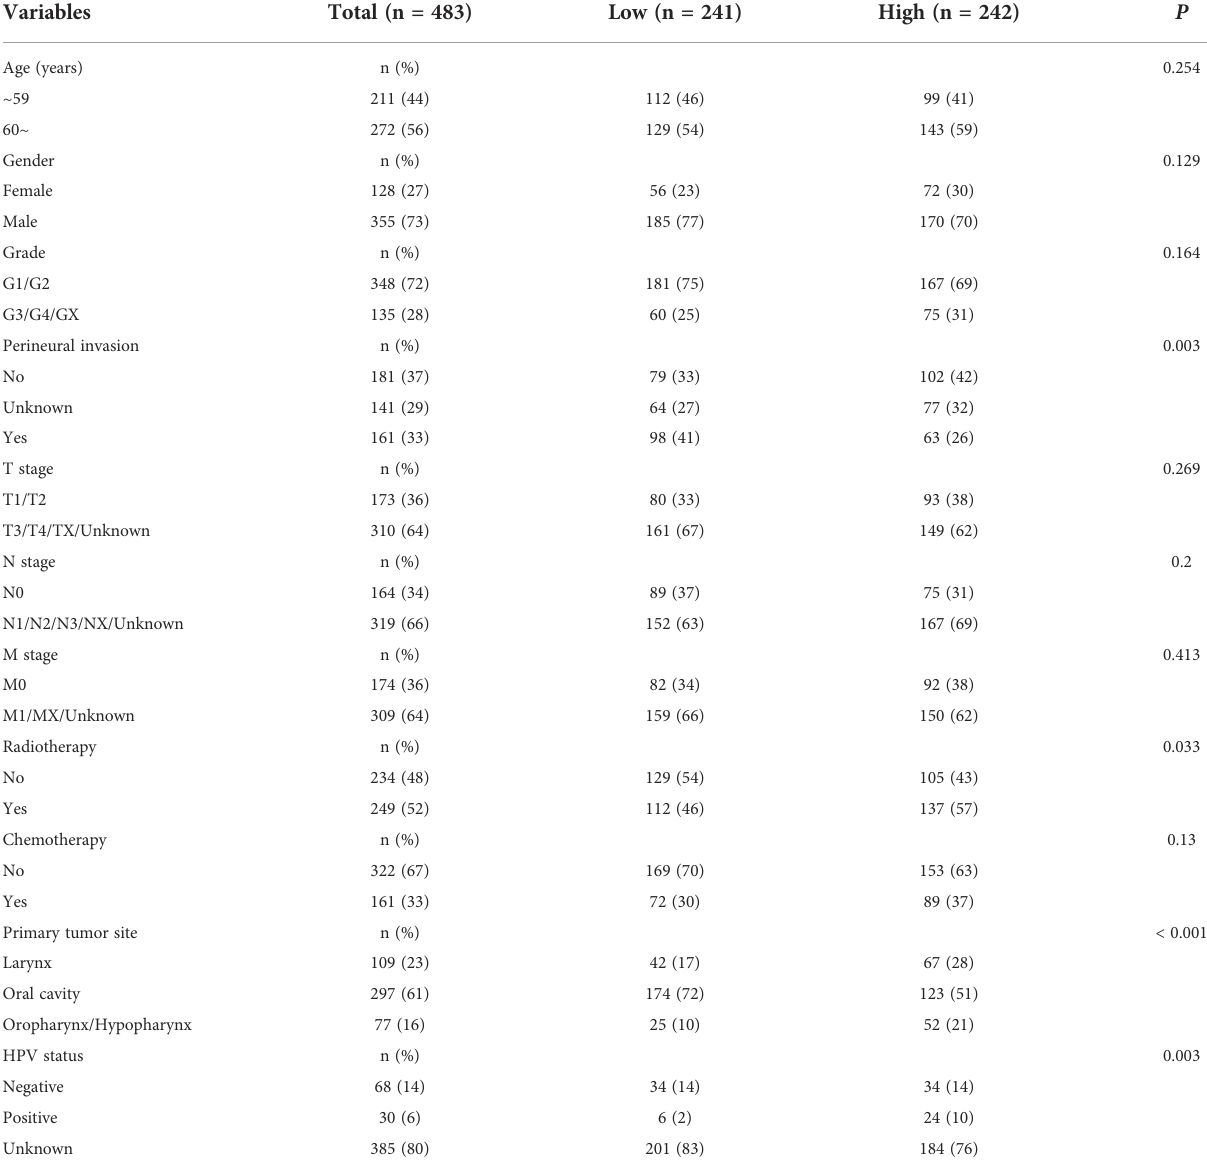
TABLE 1 Patient